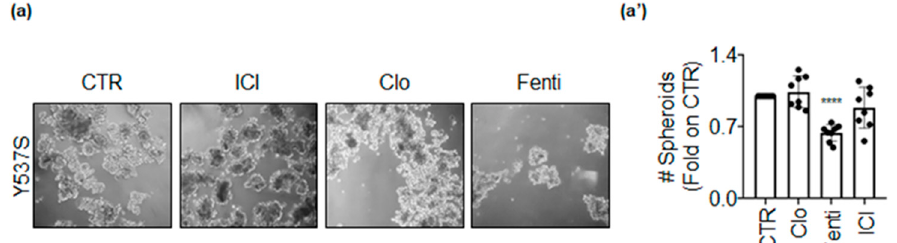
Figure 9. Clotrimazole and fenticonazole effects in Y537S-derived tumor spheroids. Pictures ( a ) and quantitation ( a’ ) of tumor spheroids generated in Y537S cells treated at time 0 with ICI182,780 (ICI–1 µ M), clotrimazole (Clo–20 µ M), fenticonazole (Fenti–20 µ M) or left untreated (CTR) for 7 days. Experiments were performed twice in quadruplicate. Significant differences with respect to the CTR sample were determined by unpaired two-tailed Student’s t-test: **** p < 0.0001.